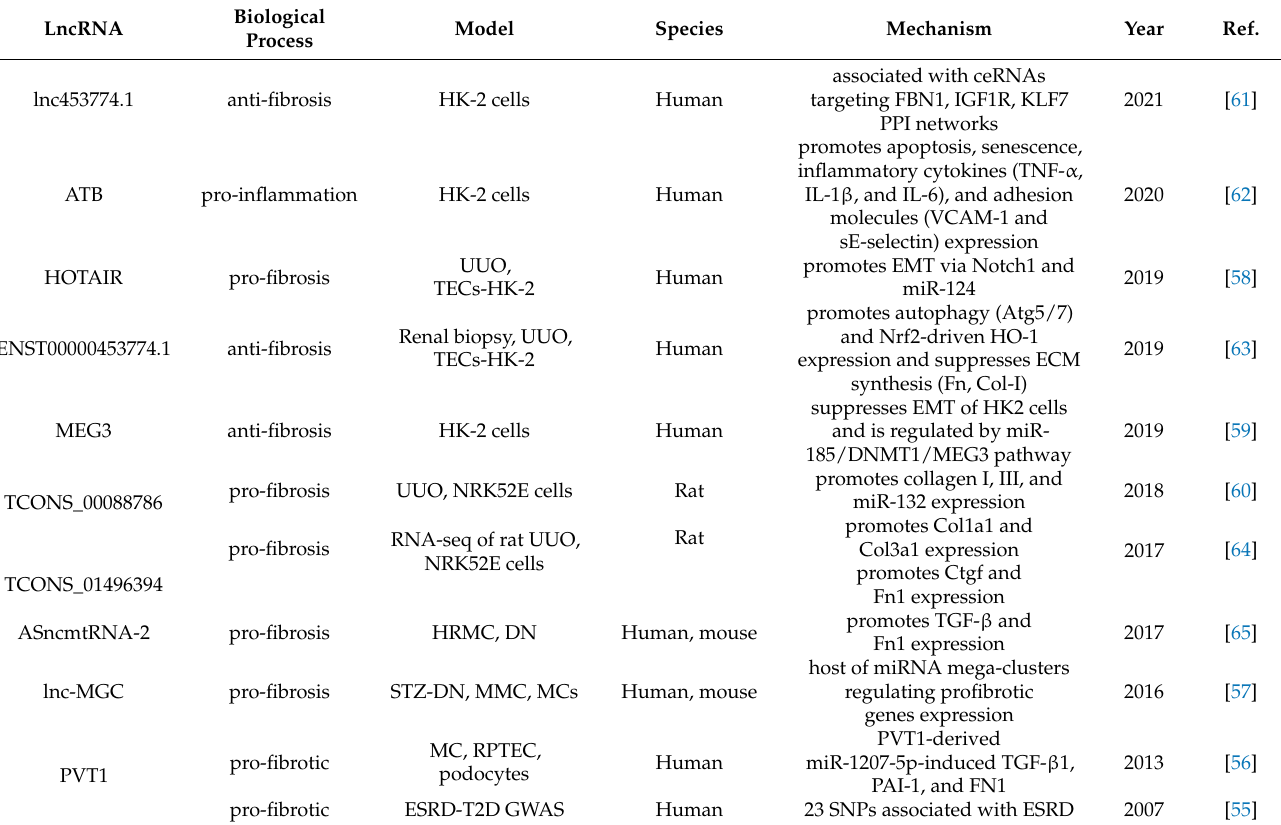
Table 1. The TGF- β -associated lncRNAs in renal